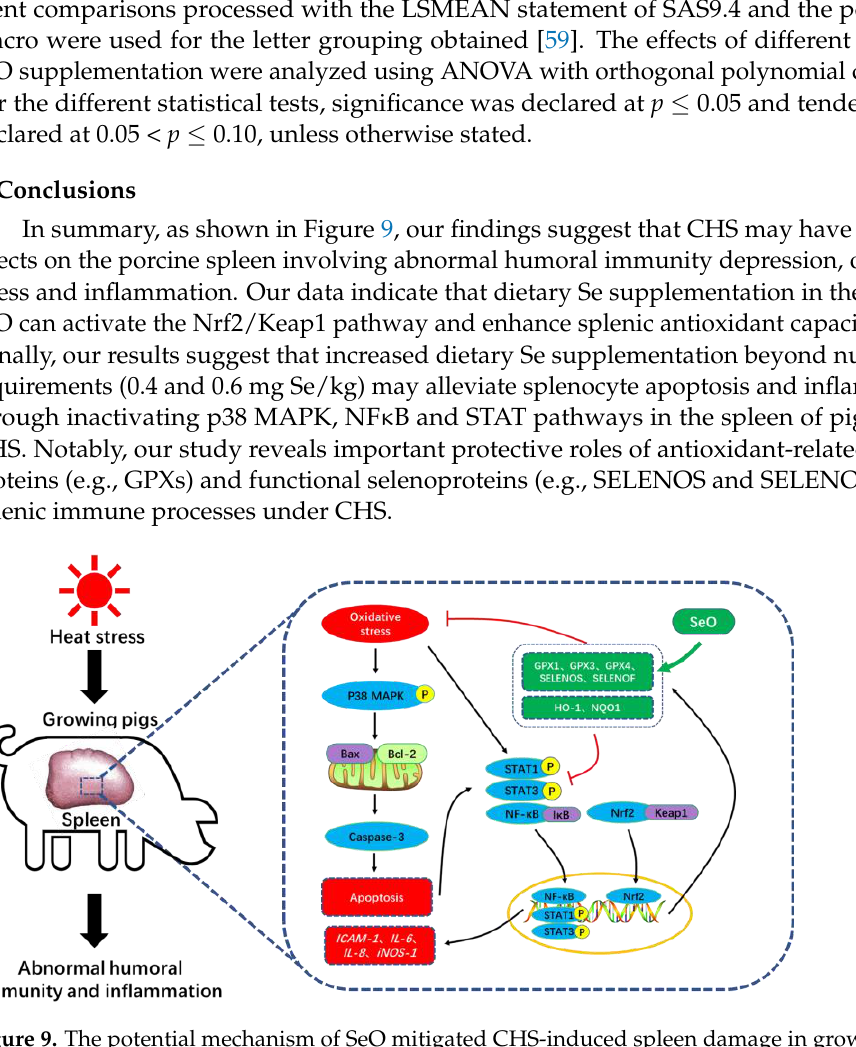
Figure 9. The potential mechanism of SeO mitigated CHS-induced spleen damage in growing pigs. Supplementary Materials: The supporting information can be downloaded at: